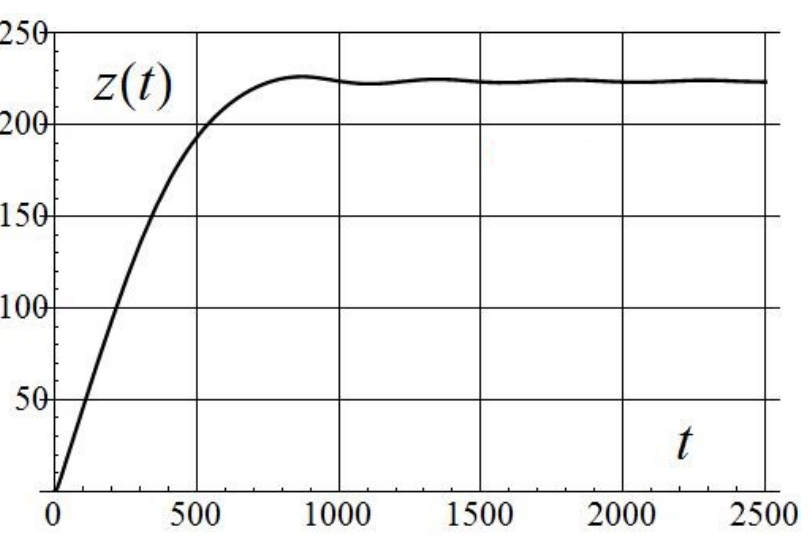
Figure 21. Submersion versus tine for a steel cylinder in hanging mode: l ∗ = l c = 2, η =